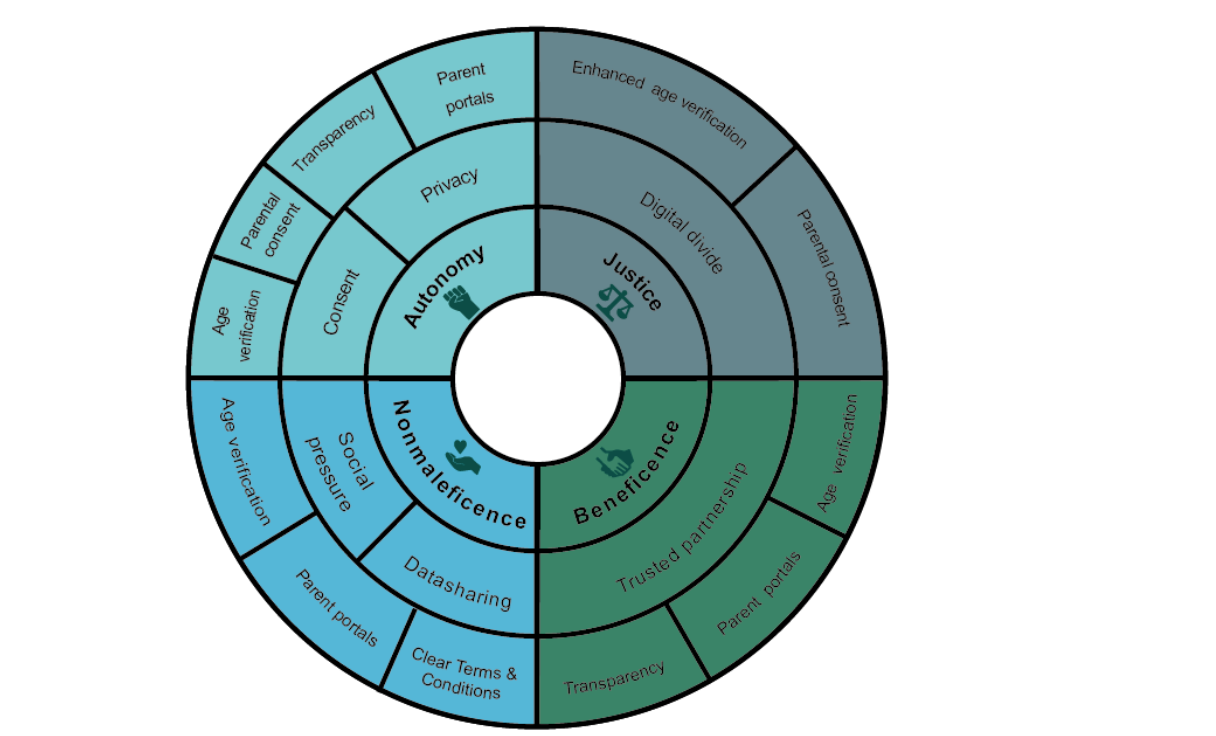
Figure 1. Mapping the four ethical biomedical principles of the use of social media to issues arising from the use of social media and links them to possible fields of actions. (Enlarged age verification: Using sophisticated mechanisms such as credit card charges could foster digital divide; Parental consent: Parents might prevent kids joining resulting in negative consequences for